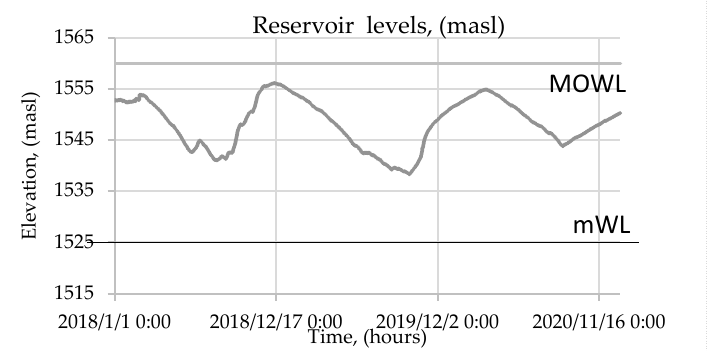
Figure 7. Historical levels in the reservoir (masl). Own source with hydrological information CFE, 2020.